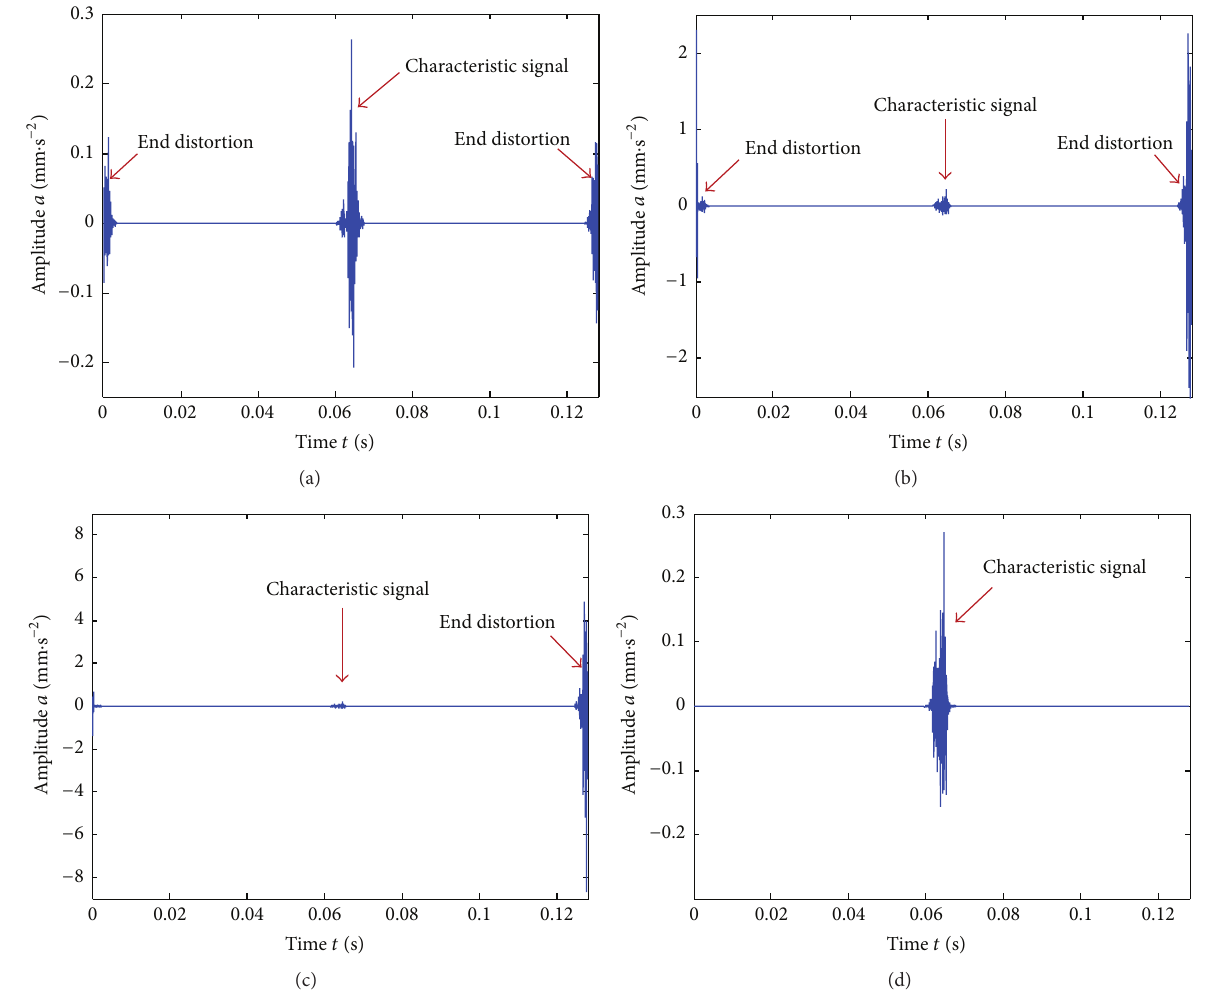
Figure 2: One subband in the fourth layer decomposed using wavelet packet and preprocessed by different methods: (a) no extension, (b) zero-padding extension, (c) periodic extension, and (d) second-order Volterra series